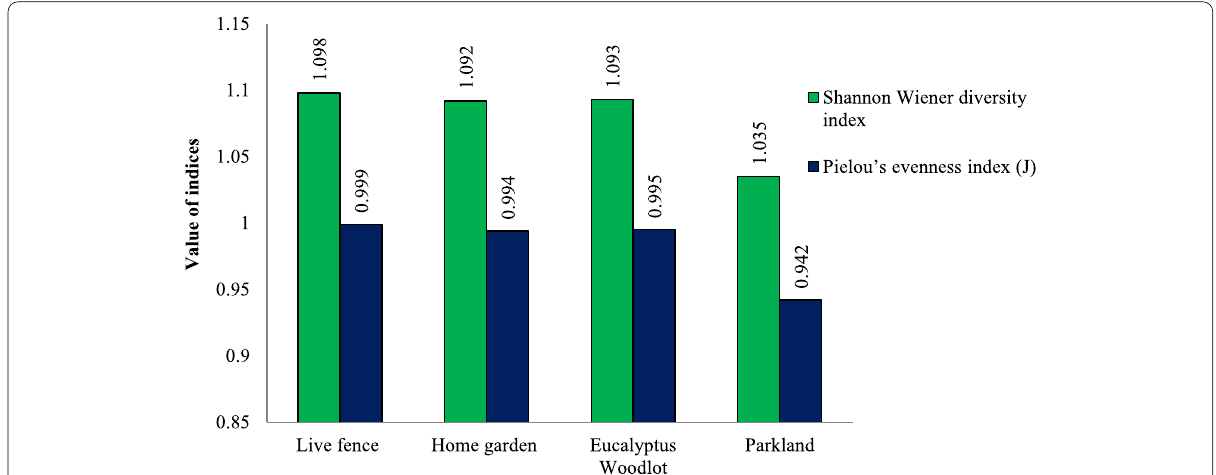
Fig. 3 Variation of Shannon’s diversity index and Pielou’s evenness index (J) along with different habitats type of the study area